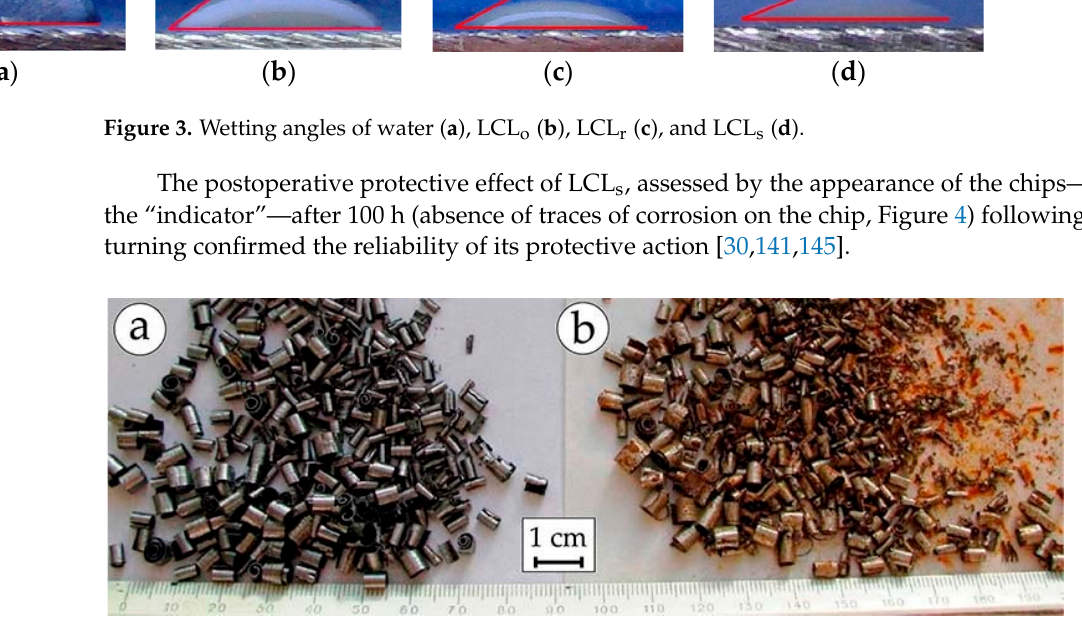
(Figure (Figure 5b). (Figure 5b).